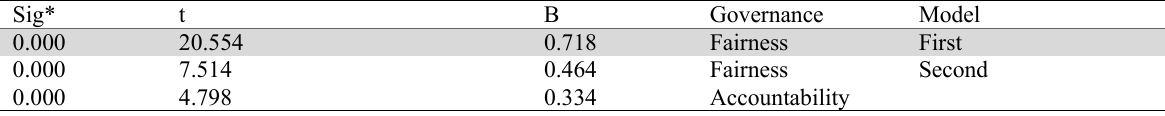
The summary of the results of the regression